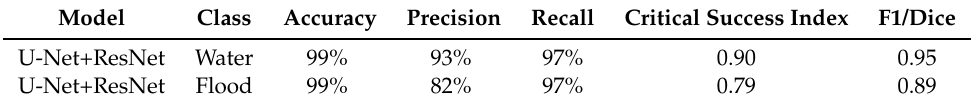
Table 5. Quantitative comparison over Sagaing Region, Myanmar—18 July